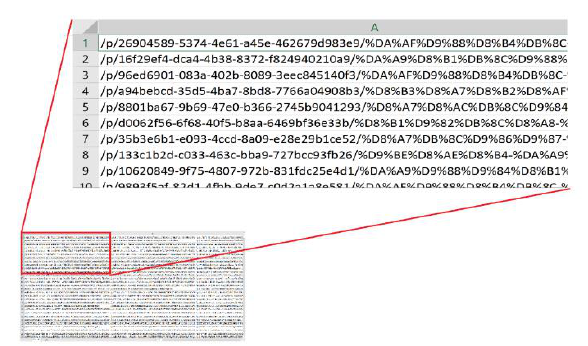
Figure 1- A piece of the raw data acquired from the